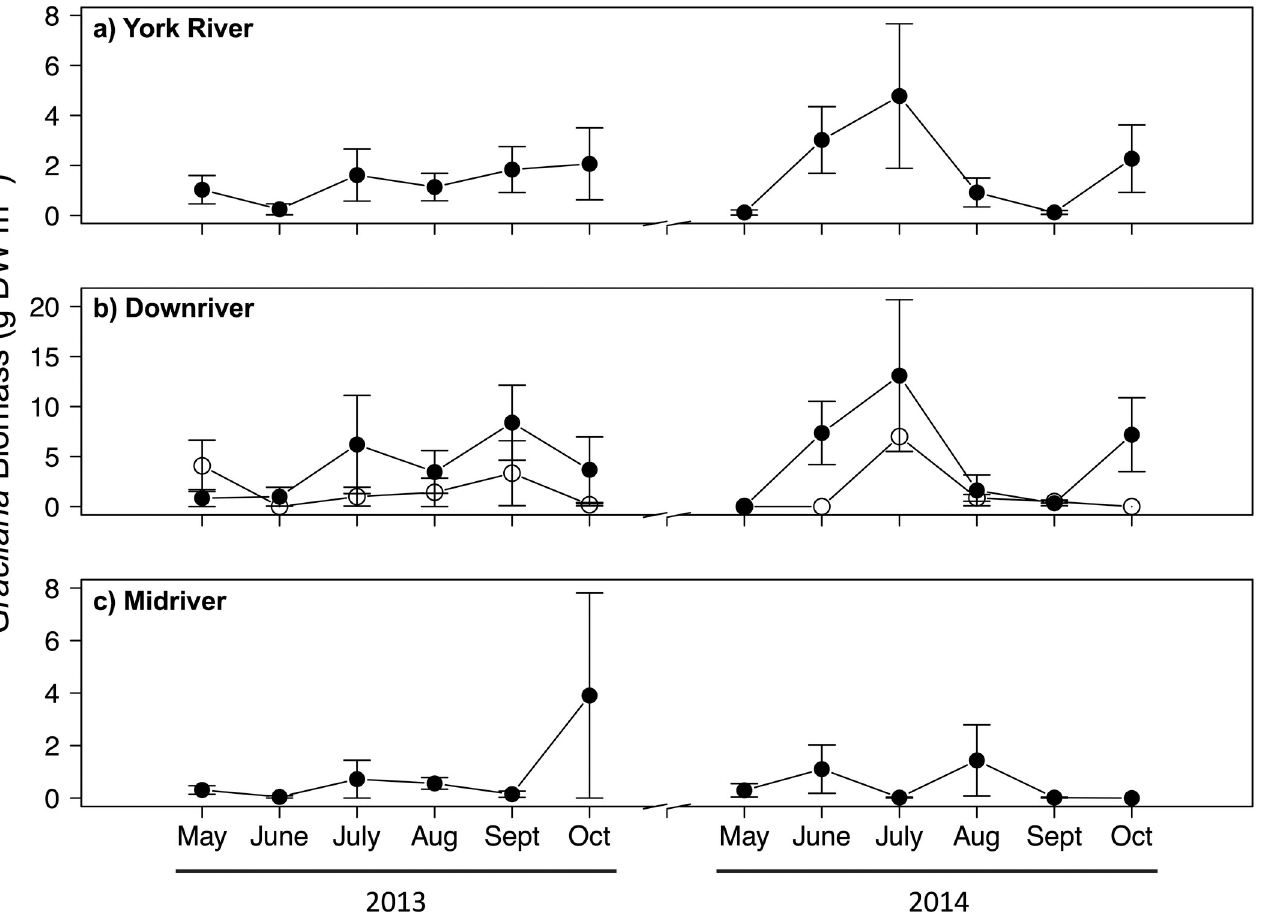
Fig 6. Mean Gracilaria vermiculophylla biomass (g dry weight [DW] m − 2 ) during 2013 and 2014 over: (a) the entire York River; (b) the downriver region, where base habitats are seagrass (filled) and unvegetated (open); and (c) midriver region. Gracilaria vermiculophylla was not observed upriver. Vertical bars represent 1 standard error of the mean. Note differing scales on y-axes.